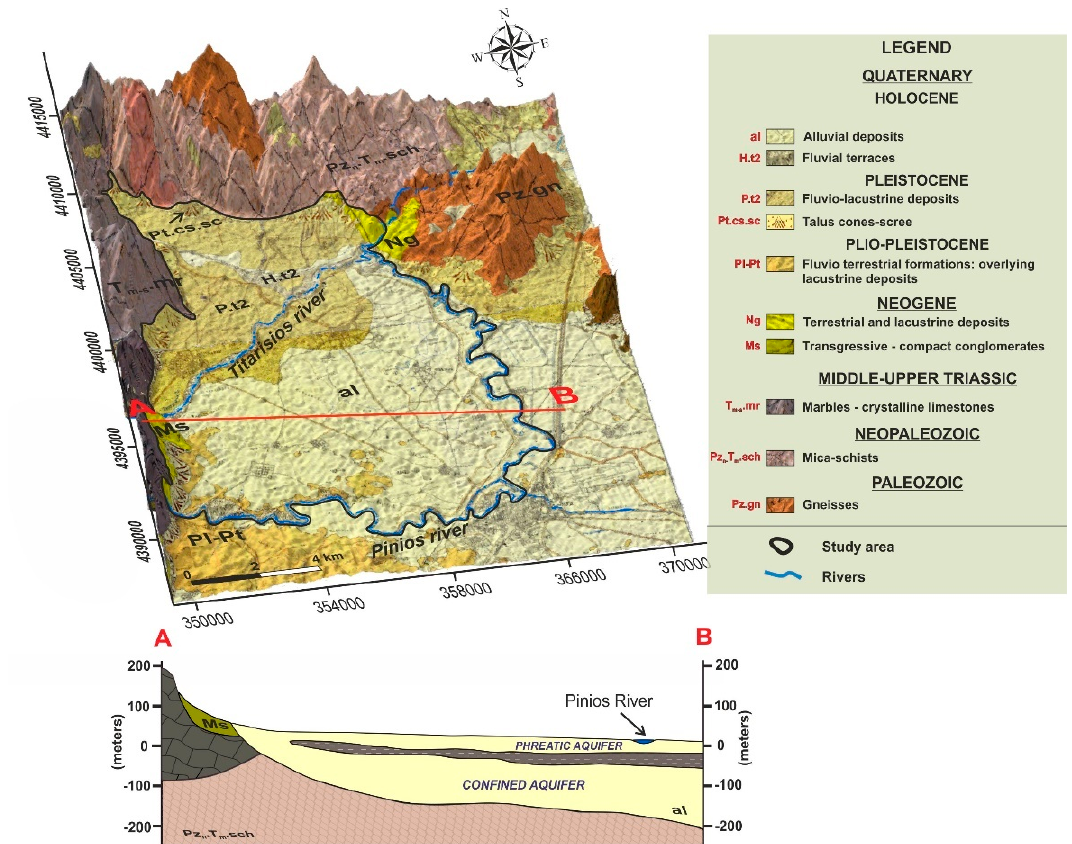
Figure 2. Geological map and conceptualized cross section of the study area, based on [27,28] and [29], respectively.